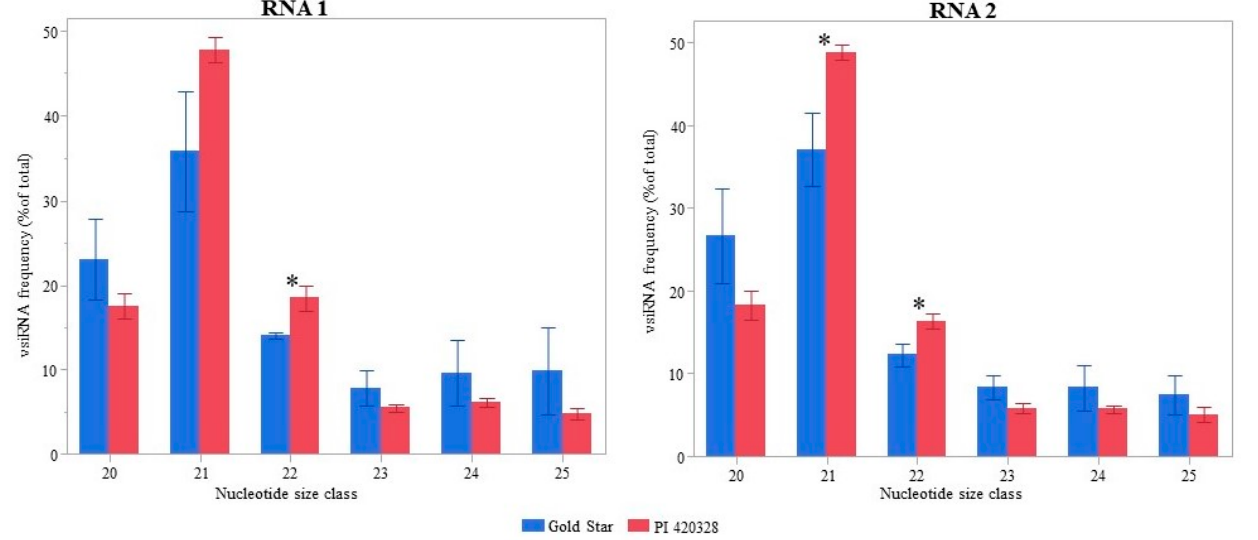
Figure 2. Relative abundance of different size classes in total vsRNAs 30 days after inoculation in susceptible (Gold Star) and tolerant (PI 420328) squash, systemically infected with cucurbit yellow stunting disorder virus (CYSDV). Each value is the average of three replicates with standard error bars. Asterix ( * ) indicates that corresponding values in Gold Star and PI 420328 are significantly different ( t- test, p < 0.05).